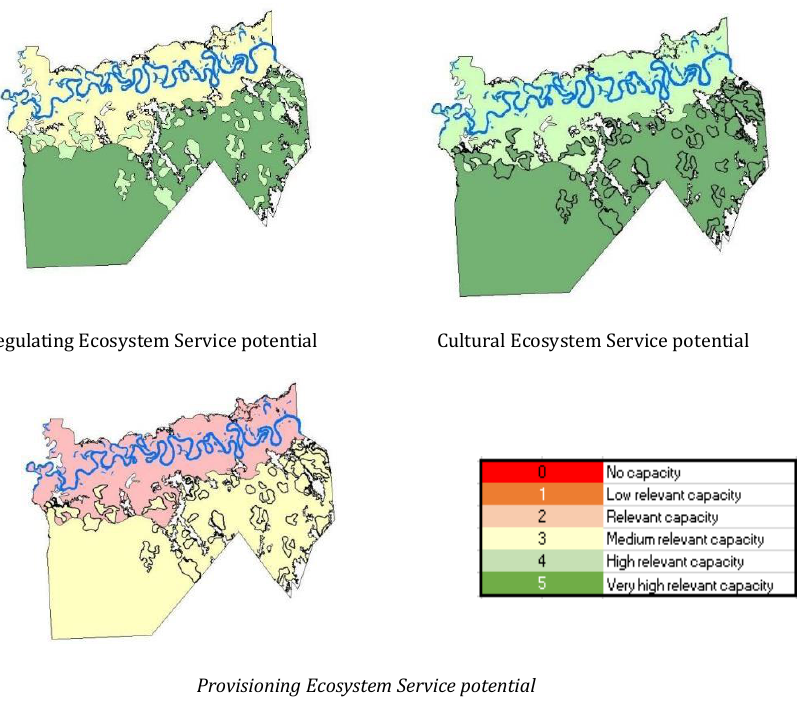
Figure 3: Spatial distribution of Ecosystem Services supply according to Land-covers